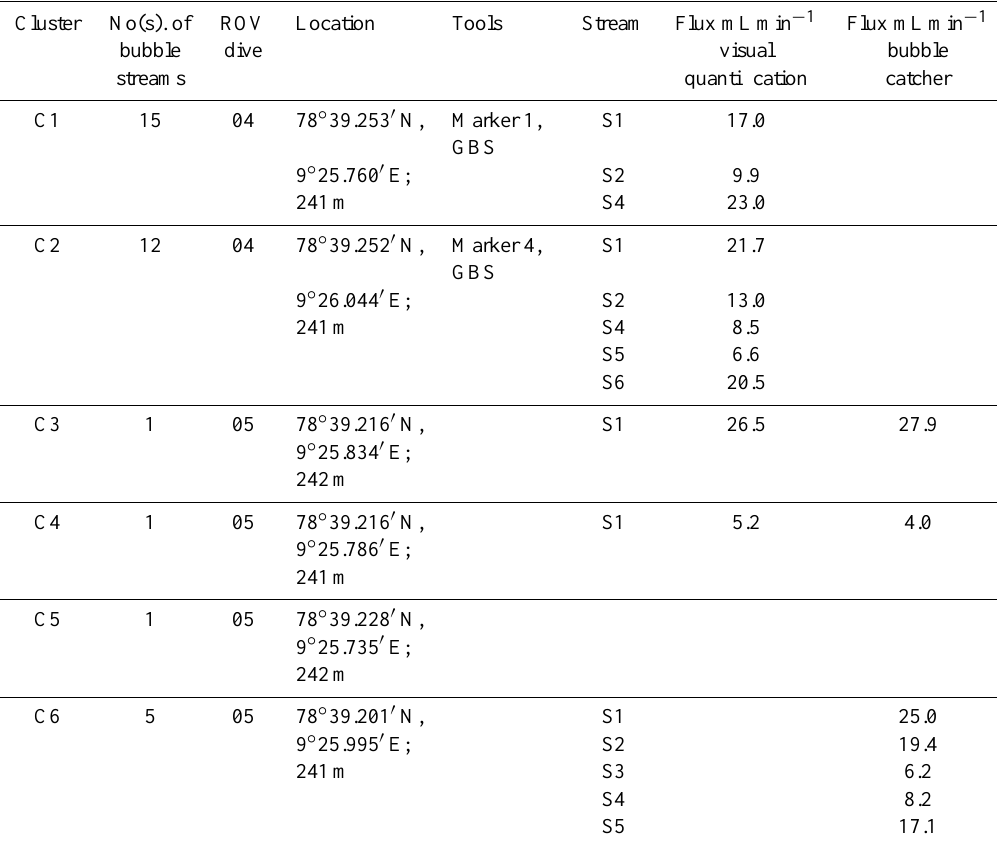
Table 3. Gas quantities transported by individual gas bubble streams in Area 2 (240–245mwaterdepth) determined by use of the bubble catcher or by interpretation of video footage.